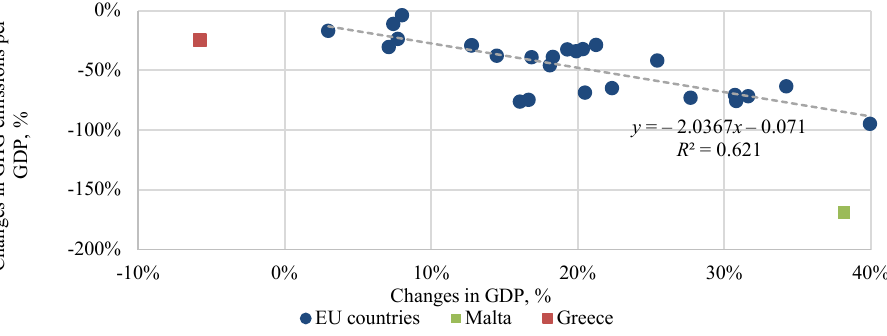
Fig. 4. GHG emissions in the energy sector as a share of GDP.